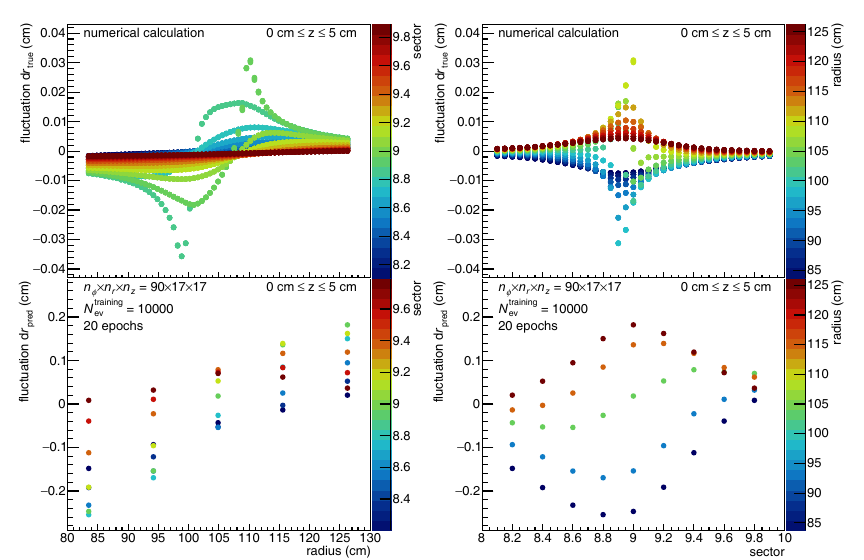
Figure 5. The distortion fluctuations, evaluated at z < 5cm, created by a space-charge density fluc- tuation at a fixed position in r (110cm) and ϕ (sector 9) and constant along all z . The top plots show results from numerical calculations and the bottom plots show the predictions by a trained model. The left plots show the distortion fluctuations as a function of the radius and sector as color scale, while the right plots show them as a function of the sector and the radius as color